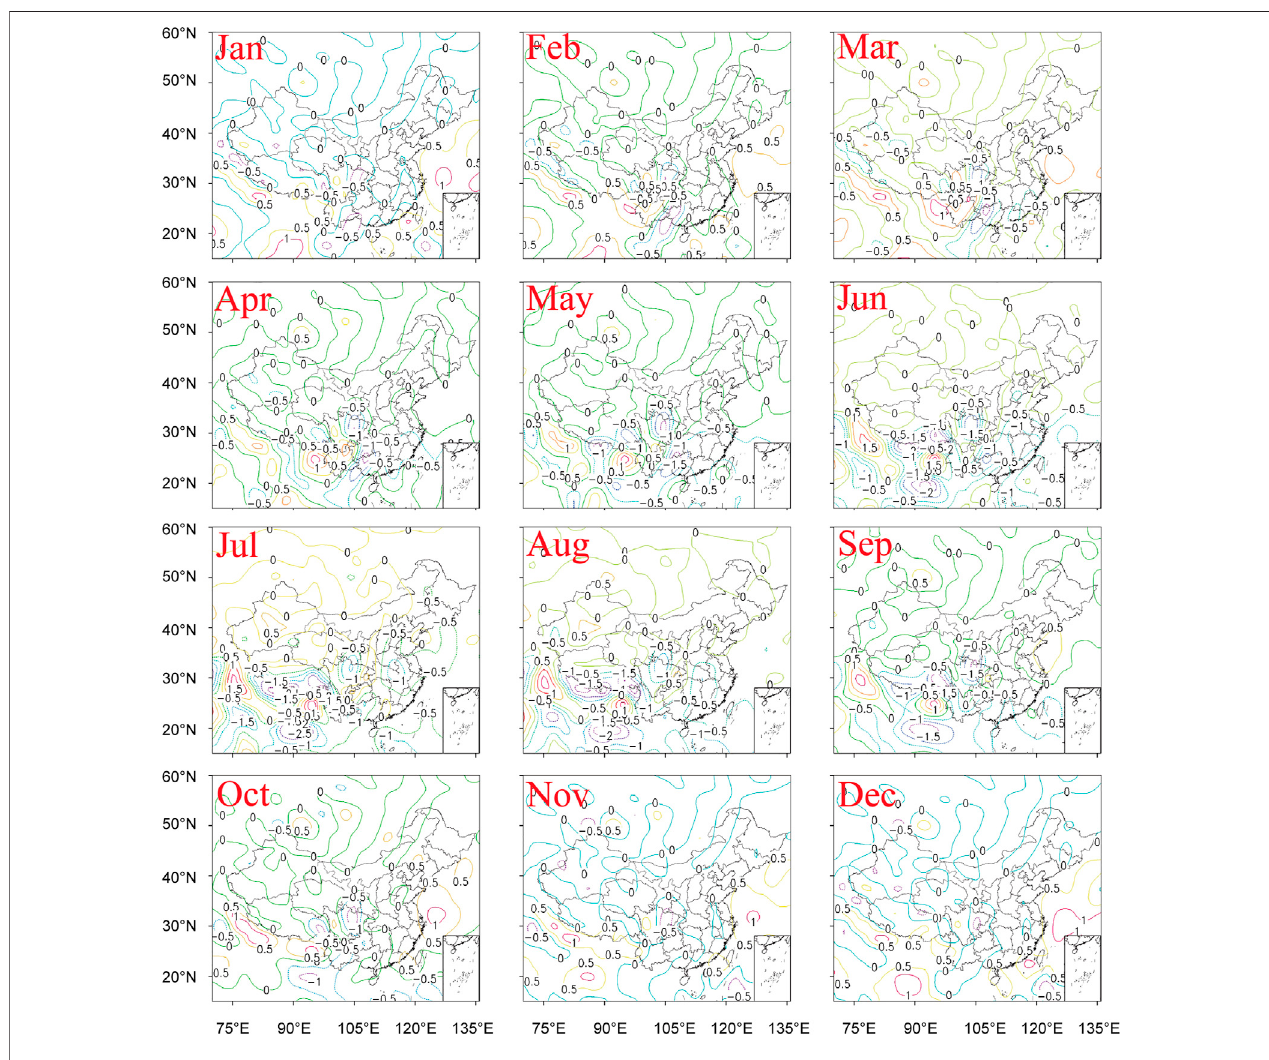
FIGURE 4 | Monthly water vapor fl ux divergence (Unit: gcm − 2 · hPa − 1 · s − 1 ).